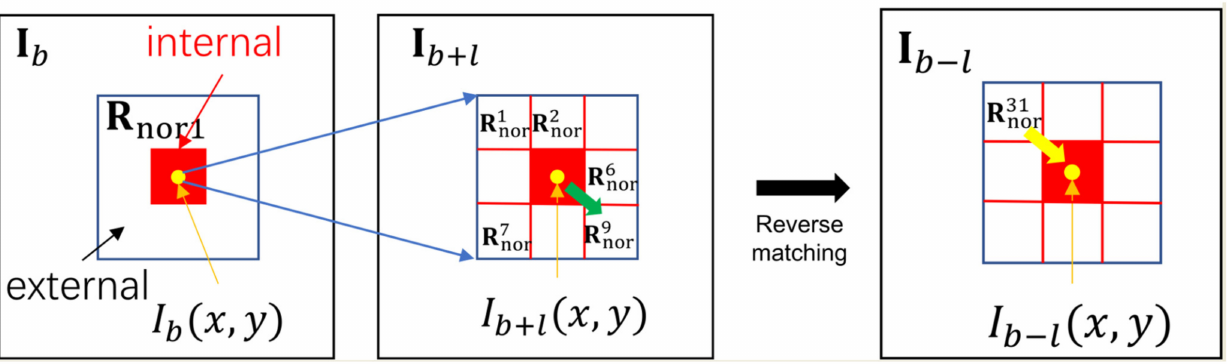
Figure 2. Overview of LSM.